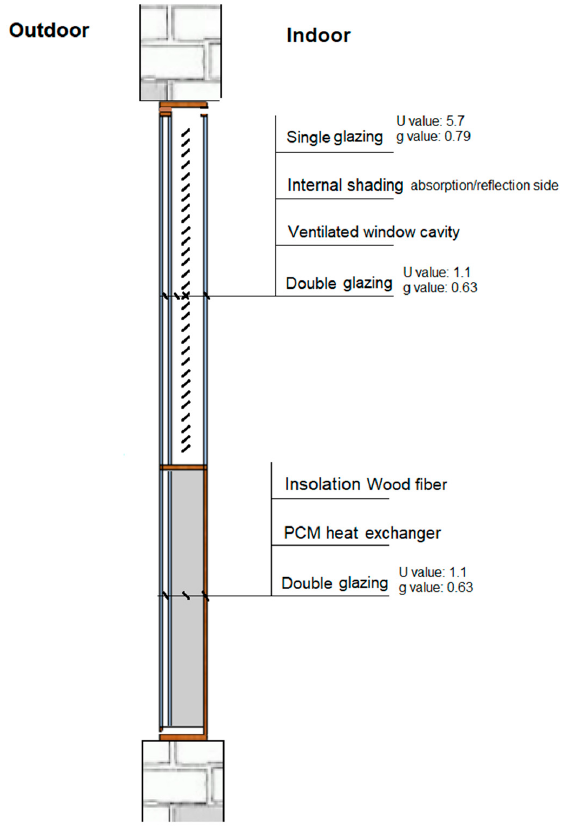
Figure 1. The sketch of the PCM-enhanced ventilated window.